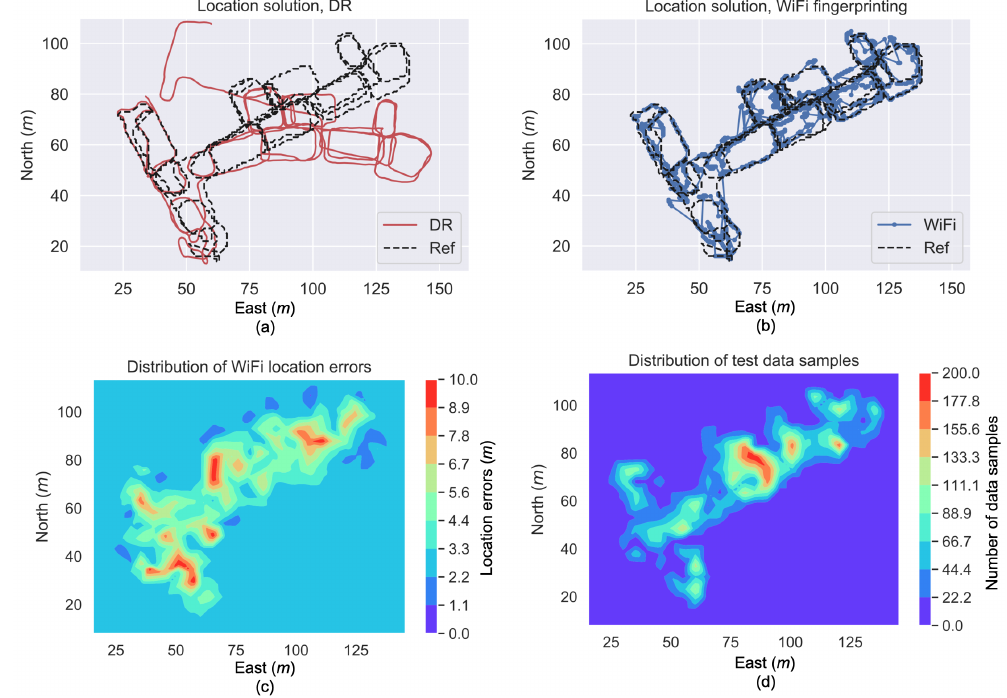
Figure 8. Location solutions from DR ( a ) and WiFi fingerprinting ( b ), heatmap of WiFi fingerprinting location errors ( c ), and heatmap of data samples used for computing the location errors ( d